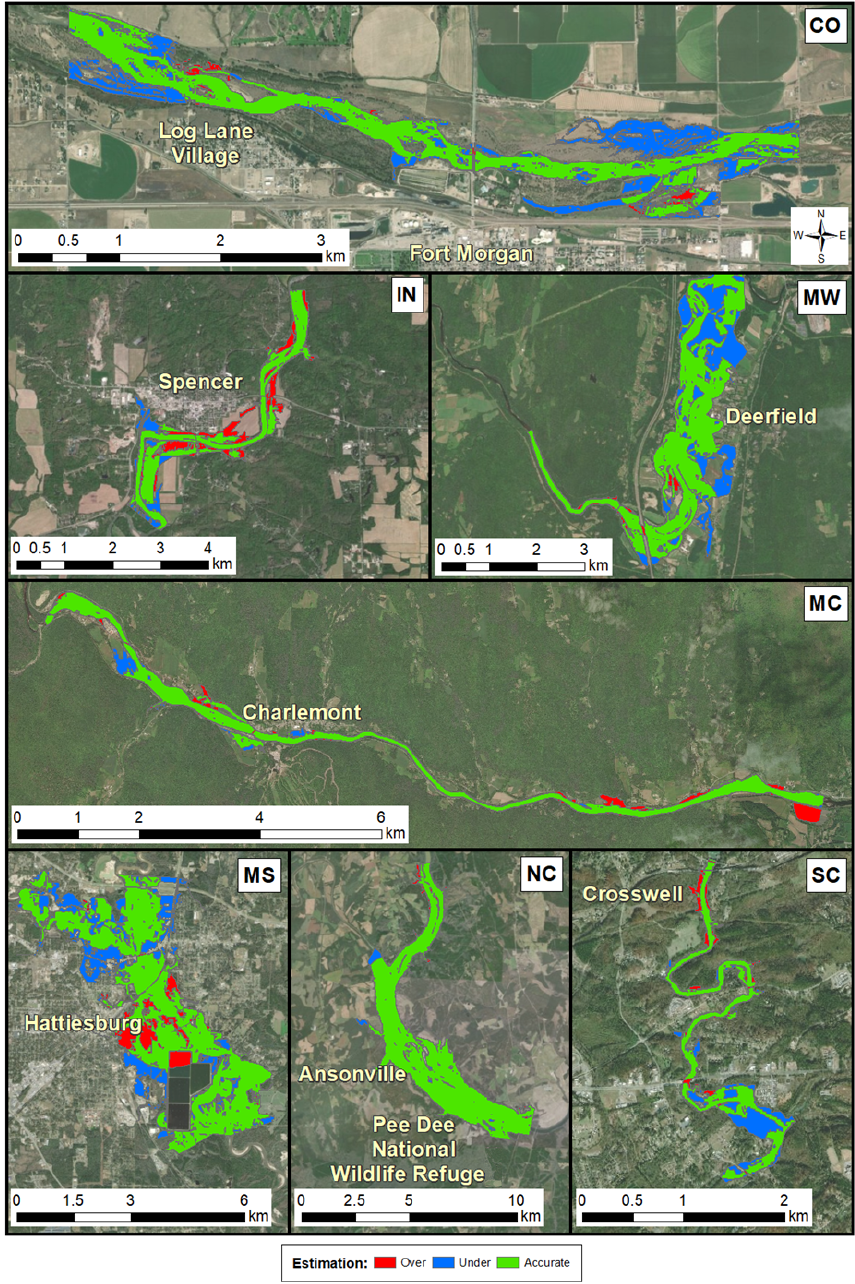
Figure 6. Flood map comparison between AutoRoute + ARPP simulations and USGS flood maps for medium-flow events at the seven test sites. Areas shaded green (Accurate) indicate areas where AutoRoute + ARPP and the USGS flood maps agree. Areas shaded red (Over) indicate where only AutoRoute + ARPP simulates the area as flooded. Areas shaded blue (Under) indicate where only the USGS shows the area as flooded. Sources of the background imagery include ESRI, DigitalGlobe, Earthstar Geographics, CNES/Airbus DS, GeoEye, USDA FSA, USGS, Getmapping, Aerogrid, IGN, IGP, and the GIS user